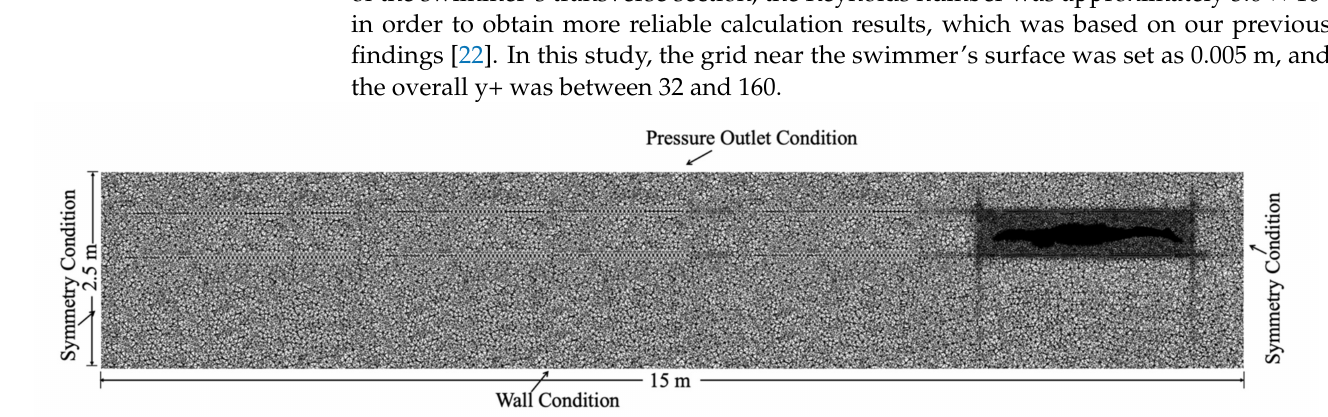
Figure 4. Computational